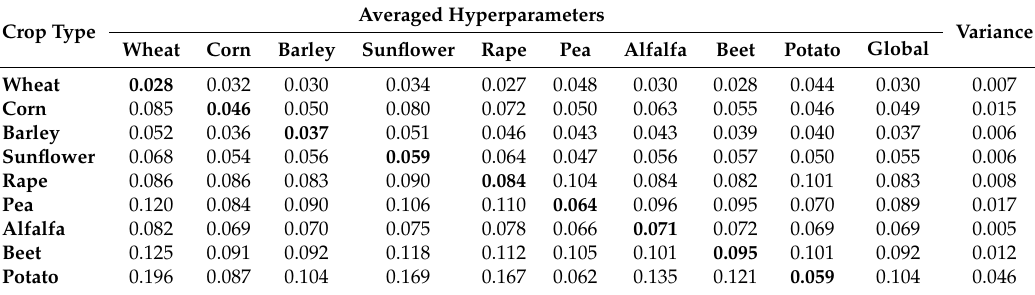
Table 2. Mean RMSE of the reconstructed LAI time series using the standard per-pixel hyperparameters optimization regarding the proposed methodology (i.e., precalculated per crop-type/global hyperparameters). Last column exhibits the variance in the RMSE. Units: [ m 2 /m 2 ]